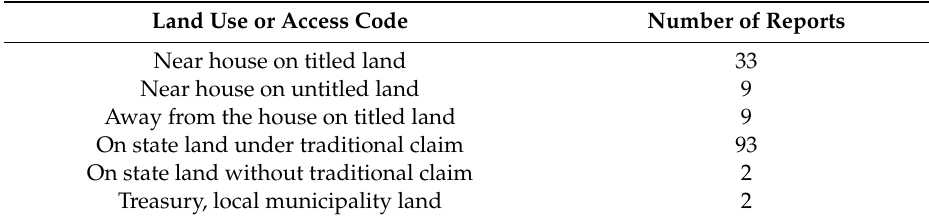
Table 4. Reported categories of land use or